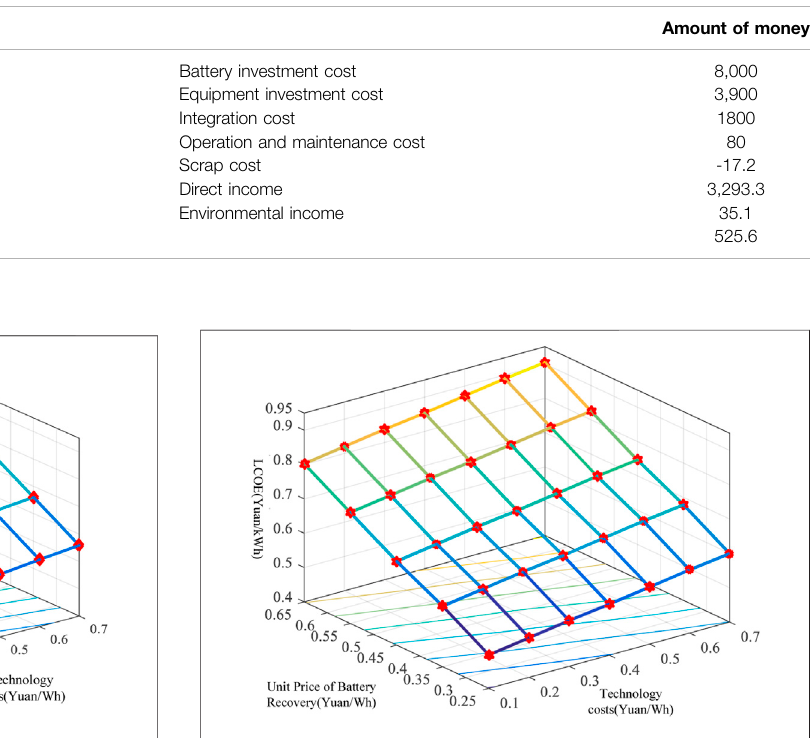
FIGURE 4 | K = 1,500 times sensitive cost parameter relationship.